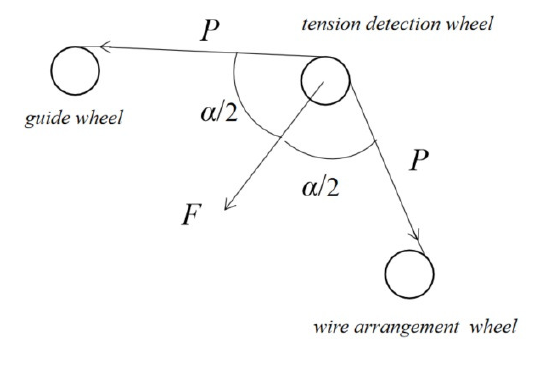
Figure 2. Schematic diagram of tension